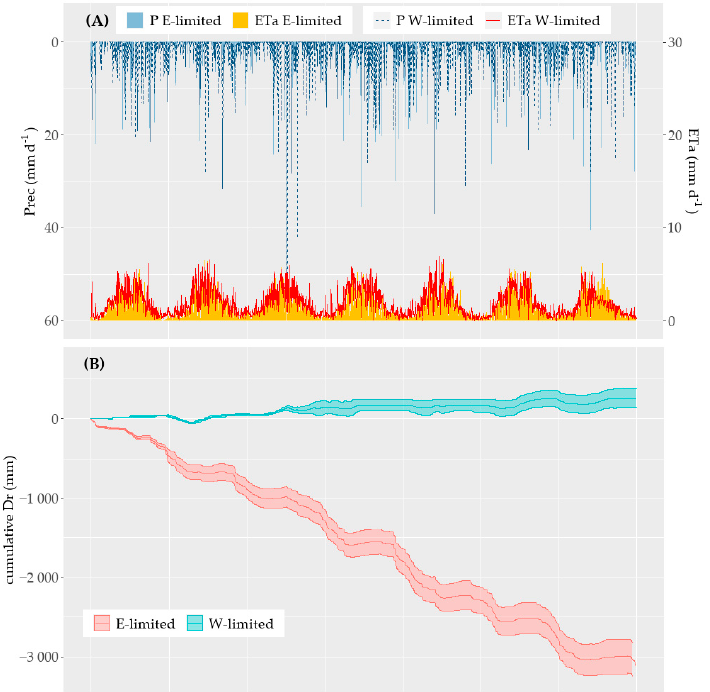
Figure 2. Comparison of the annual water balance components for lysimeters with soils from Rollesbroich located in the energy-limited site Rollesbroich (E-limited, x-axis) and the water-limited site Selhausen (W-limited, y-axis) for ( A ) precipitation (Prec), ( B ) drainage (Dr), ( C ) upward directed water mimicking capillary rise (CR), ( D ) actual evapotranspiration (ETa), and ( E ) the resulting soil water storage ( Δ WS). Positive values represent an input and negative values a loss of water for the soil lysimeter system. “mean” in the legend indicates the mean annual values for the period 2012–2018 and the inter-annual variability is represented by the standard error of annual means.